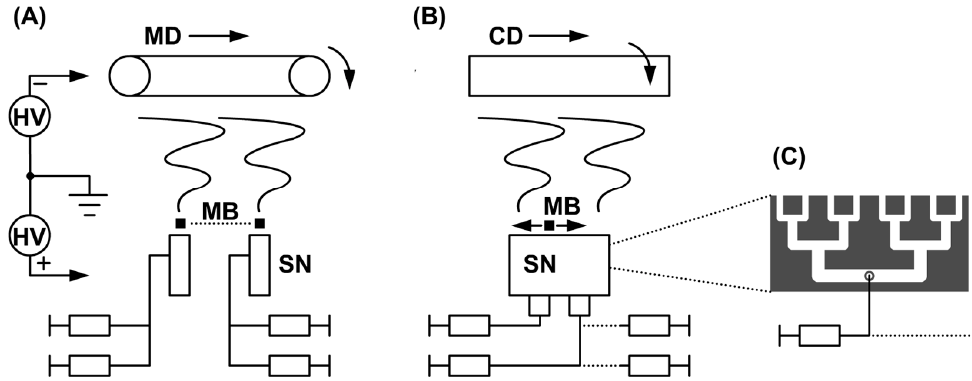
Figure 2. A diagram of the spinning system in the deposition chamber of the industrial device with two needleless spinning nozzles (SN) and a collector electrode with the endless belt design—shown from the cross direction (CD) ( A ) and machine direction (MD) ( B ). MB is moving body and HV is high voltage source. The third image shows the design of distribution chambers inside the needleless spinning nozzle ( C ); there were four of these segments in each nozzle.